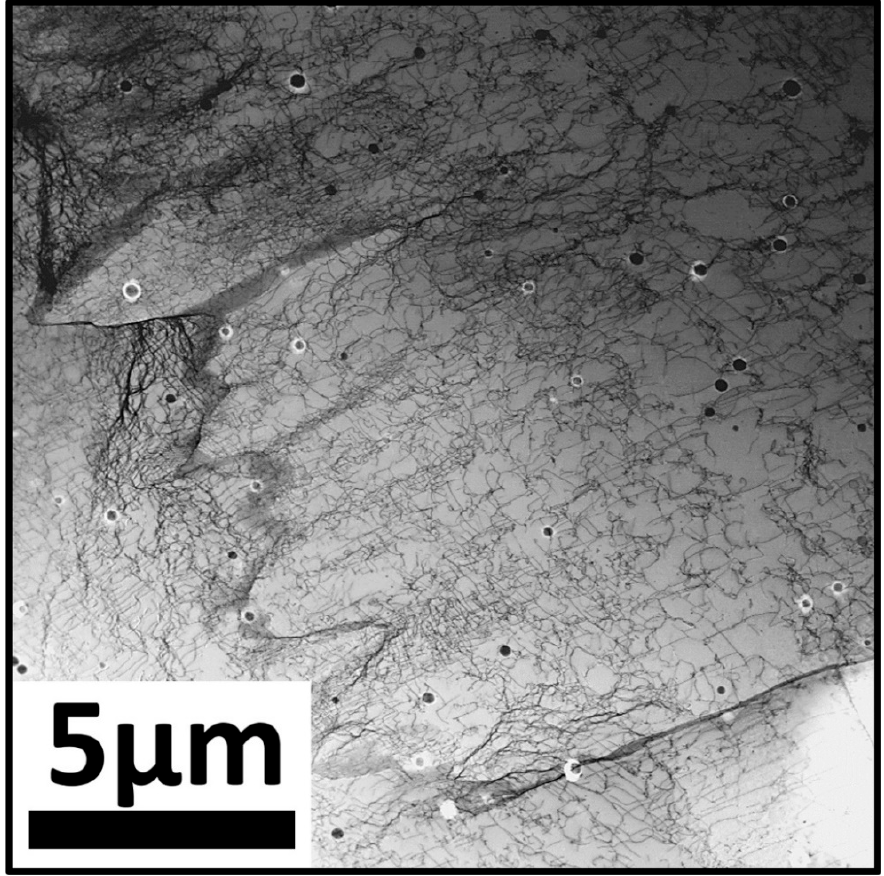
Figure 7. TEM micrograph showing the dislocation structure in massive ferrite in Steel B.